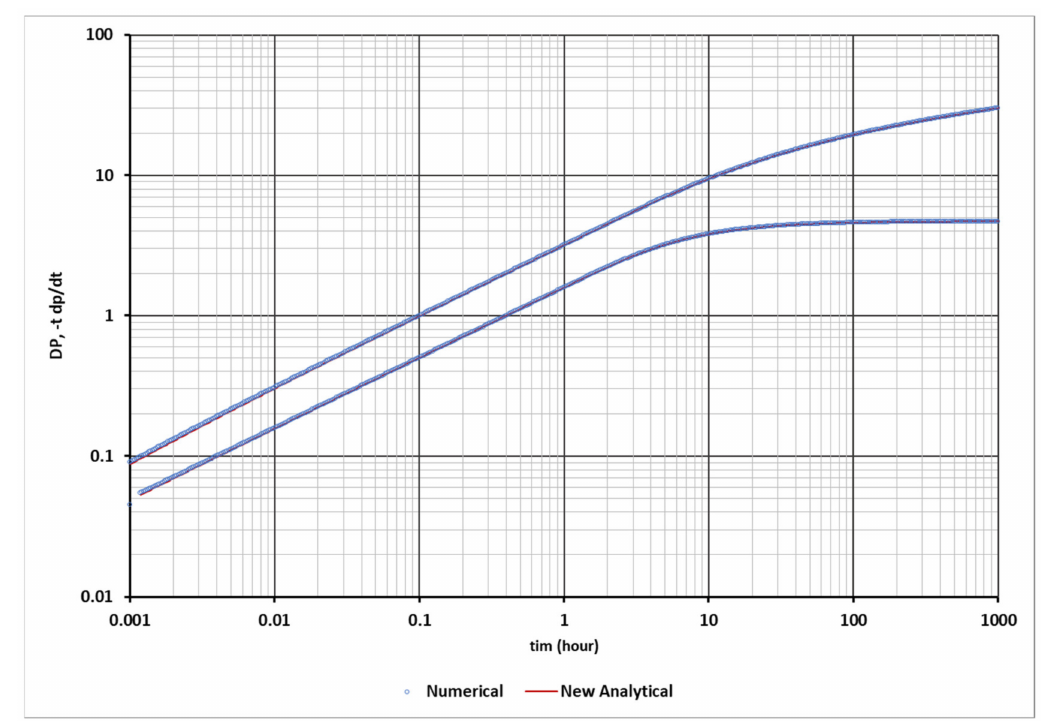
Figure 7. Results Comparison between Analytical Model and Numerical Calculation in Log-Log scale.